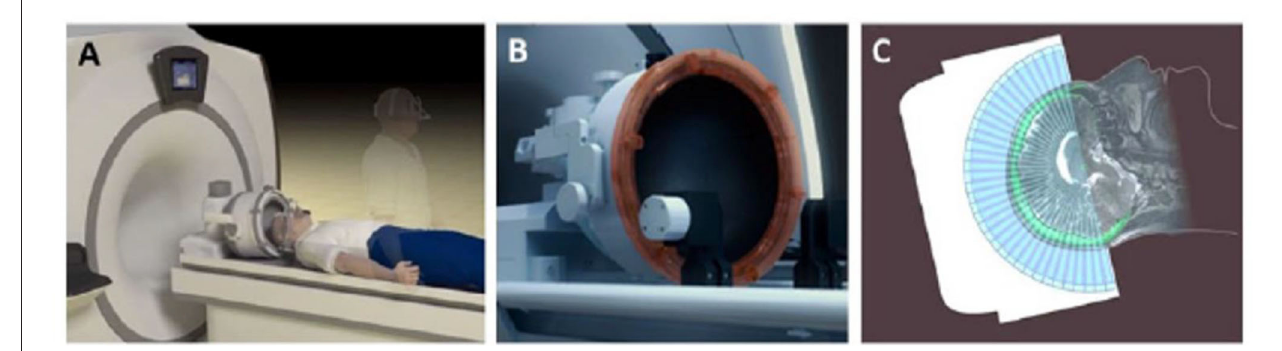
FIGURE 1 | Set-up of MRgFUS patient treatment. (A) A schematic representation of patient lying supine on MR table being fitted with FUS phased-array transducer array; (B) , Close up of the 1,024 ultrasound element array for electronic steering of the ultrasound beam. (C) A schematic 2-dimensional representation of the multiple ultrasound beams focused non-invasively through the skull (bright green) to a single target. The image of the skull is obtained from a prior computed tomographic scan that is mechanically registered to the MR image. Information from the skull is used by the planning software to correct for aberrations to the beam paths and accurately position the focus at the desired target. Adapted from Fishman and Frenkel, Journal of Central Nervous System Disease 2017 (68). Reprinted with permission from SAGE